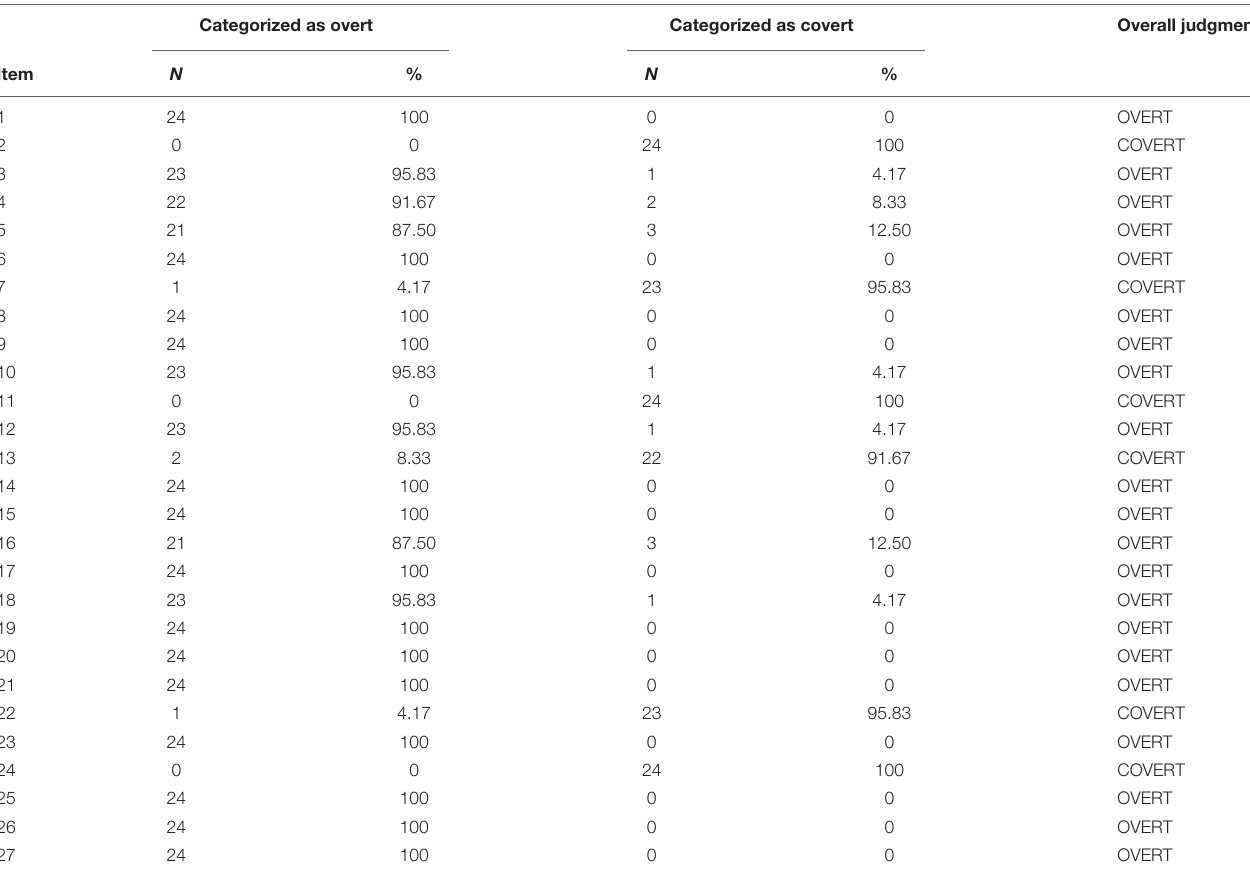
TABLE 1 | Categorization of the items of the Roman Alexithymic Scale as “overt” or “covert”. Categorized as